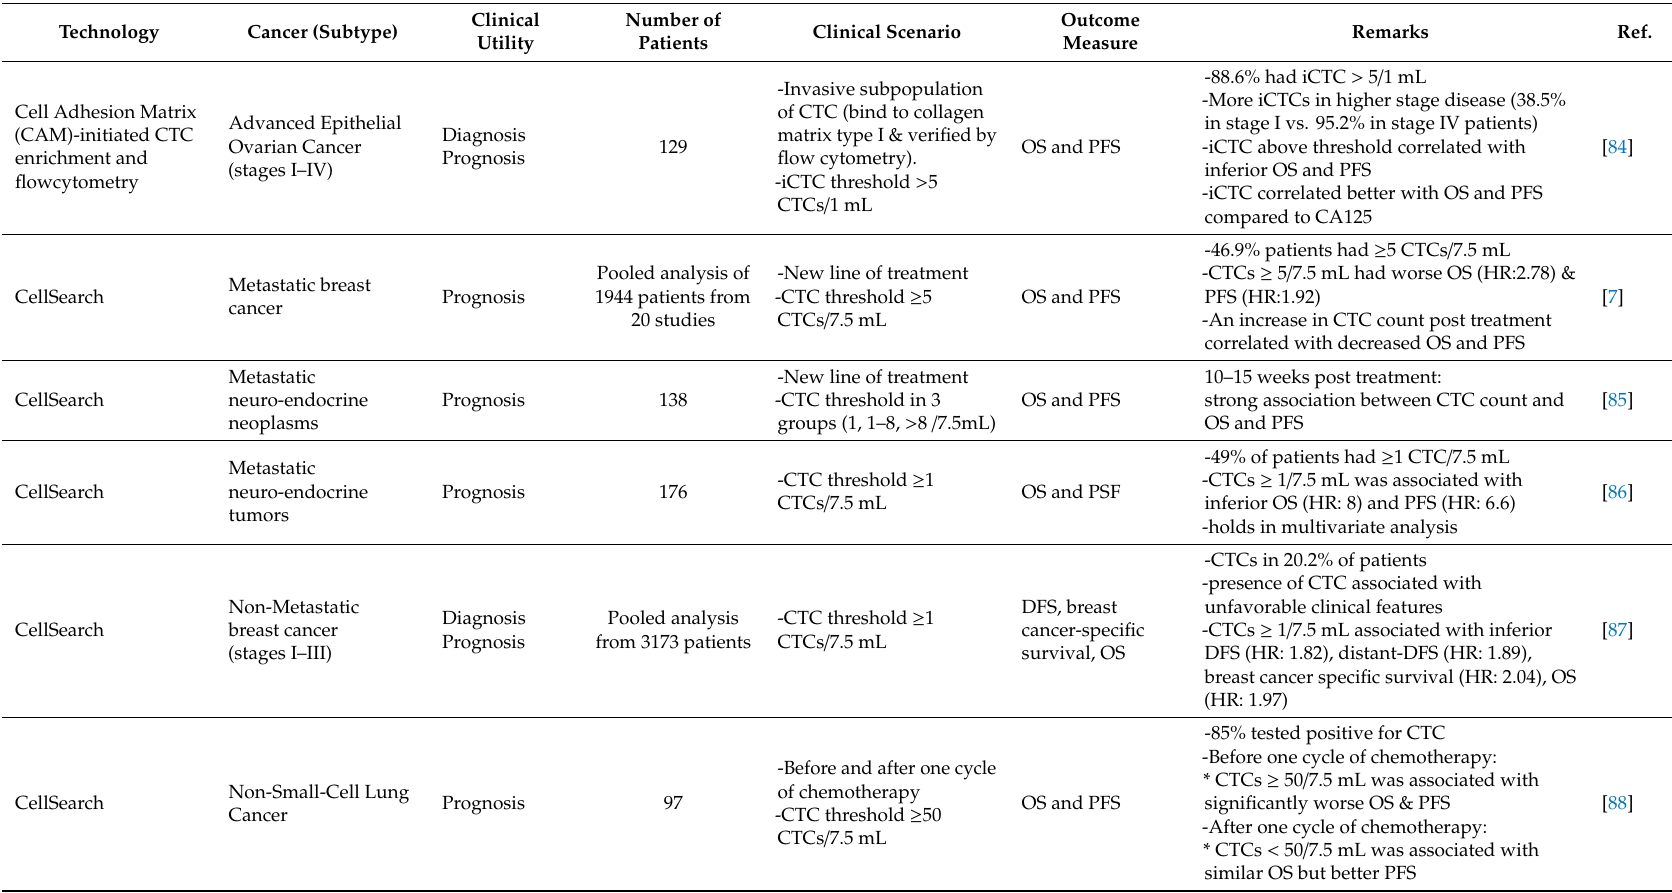
Table 5. Selected CTC clinical studies on outcome measures after the year